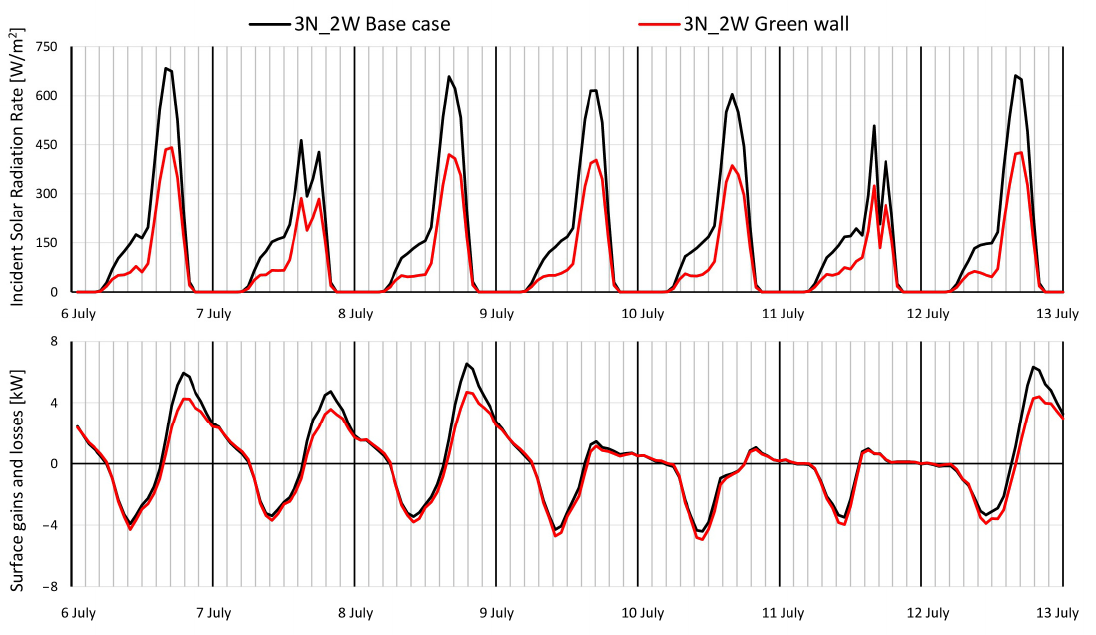
Figure 3. Trend of incident solar radiation (W/m 2 ) and heat gains and losses (kW) in the summer reference week for the western wall.